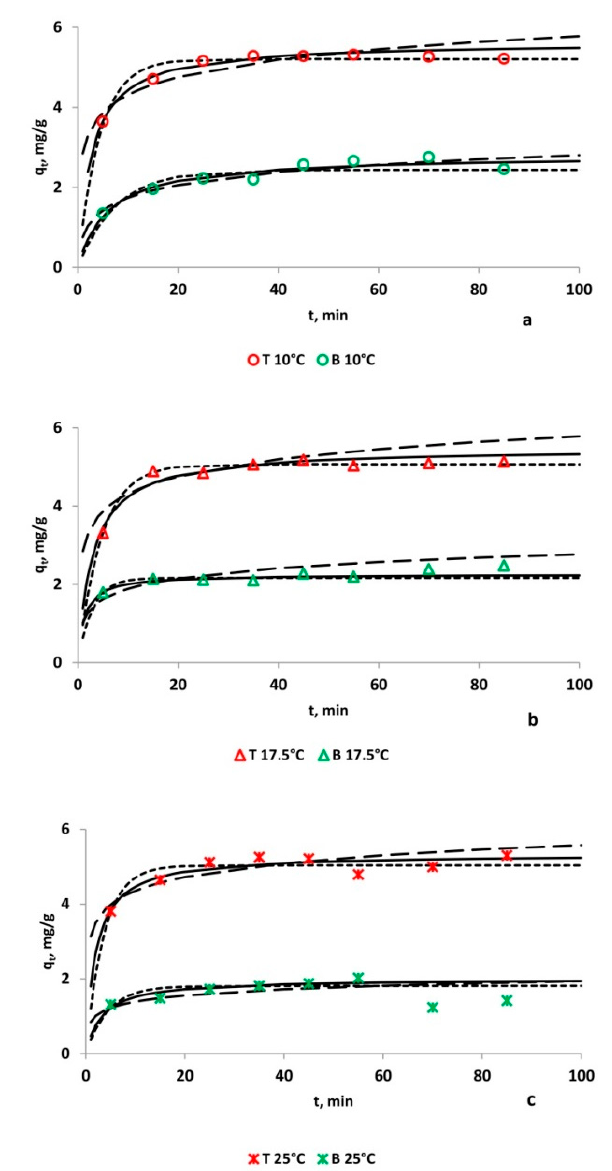
Figure 5. Regression analysis of the sorption on Mn on tuff and basalt by PFO (dashed line), PSO (solid line) and Elovich (dotted line) models.